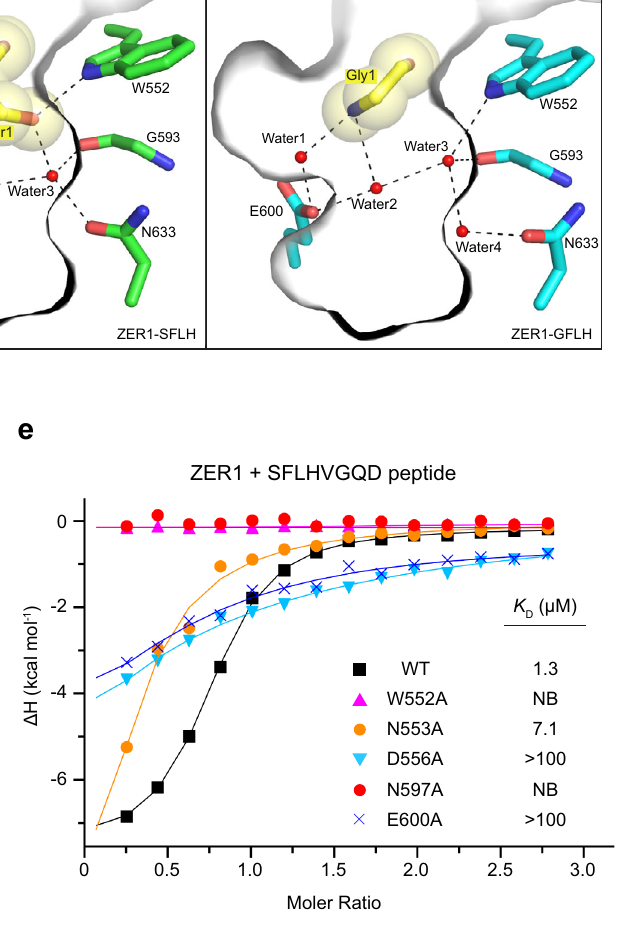
Fig. 3 | Structural basis of Nt-Ser recognition by ZER1. a Superposition of Nt-Ser and-GlybindingpocketinZER1.Nt-Serand-Glybearingpeptides(SFLHandGFLH) are shown ingreen andcyan, respectively. b , c Close-up viewof the interactions of ZER1 with Nt-Ser (Ser1) and Nt-Gly (Gly1) in the binding pocket. The hydrogen